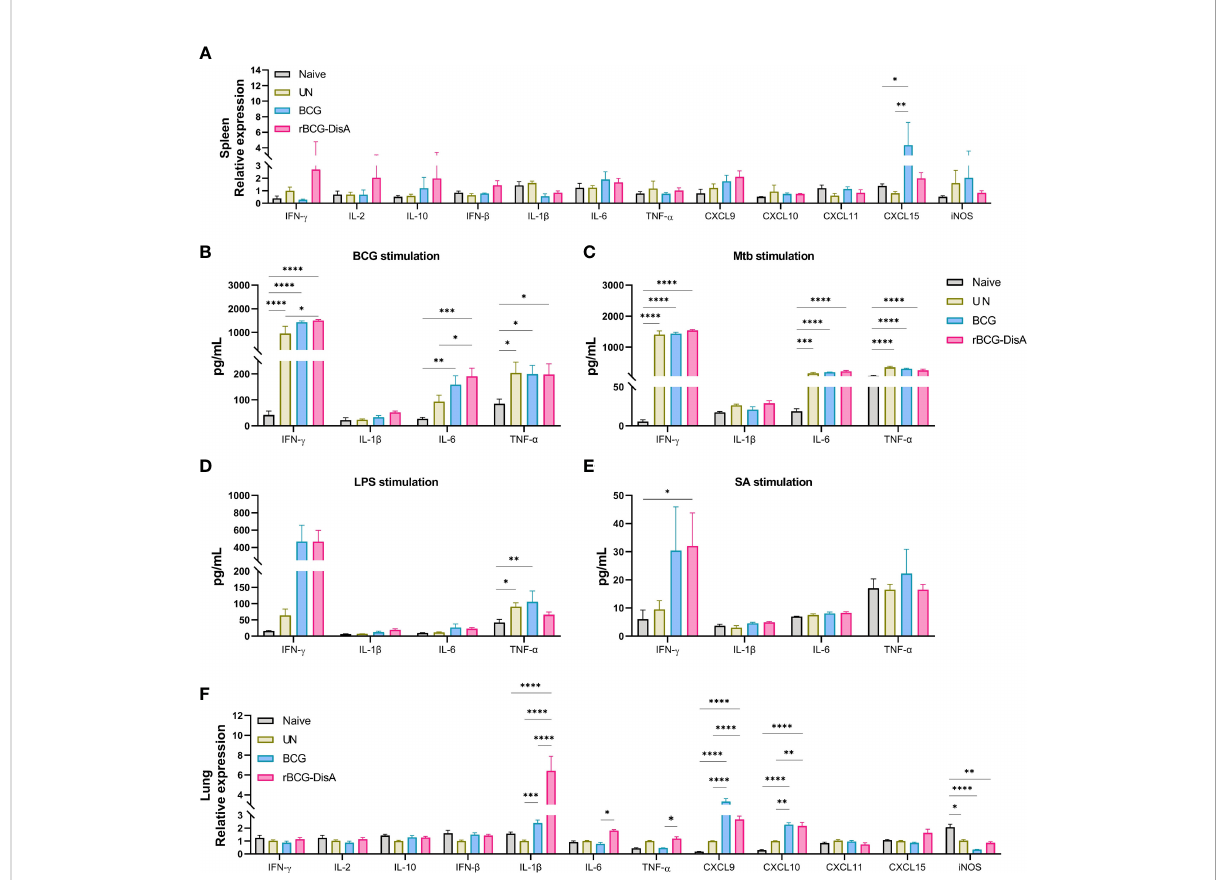
FIGURE 2 In fl ammatory cytokines expression in the spleen and lung of vaccinated mice after M. tuberculosis infection. Mice were vaccinated by i.v BCG and rBCG-DisA for 12 weeks. Then, mice were infected with M. tuberculosis by i.n route, normal mice (Naïve) and M. tuberculosis infected mice without immunization (UN) were used as control. (A) At 6 weeks post infection, transcription level of indicated genes in the spleen of mice was assayed by quantitative RT-PCR ( n =3). (B – E) At 6 weeks post infection, splenocytes were isolated and re-stimulated with BCG protein extracts (BCG) (25 m g/mL) (B) , M. tuberculosis (Mtb) (25 m g/mL) (C) , E. coli O111:B4 LPS (LPS) (100ng/mL) (D) , and S. aureus (SA) (25 m g/mL) (E) for 72h in vitro . Cytokines production of IFN- g , IL-1 b , IL-6 and TNF- a in supernatants were determined by ELISA ( n =4). (F) At 6 weeks post infection, transcription level of indicated genes in the lung of mice was assayed by quantitative RT-PCR ( n =3). (* P < 0.05, ** P < 0.01, *** P < 0.001,**** P <